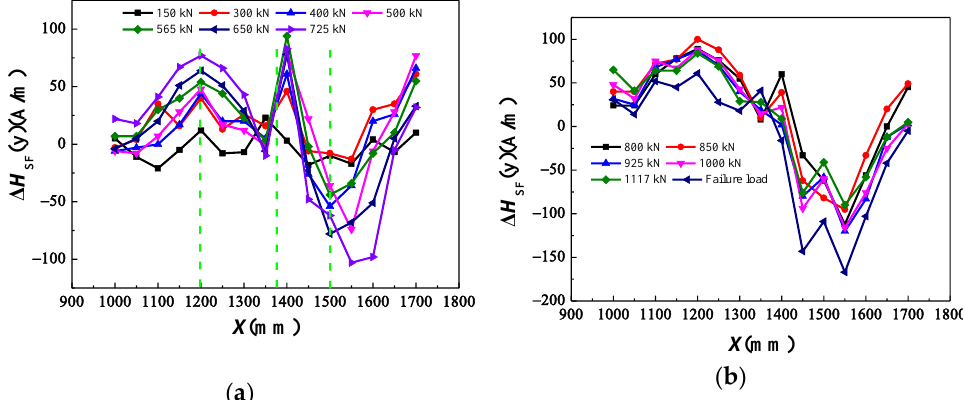
Figure 11. ∆𝐻 SF (y) curves of the bottom flange: ( a ) elastic loading stage; ( b ) elastoplastic and plastic deformation stages.